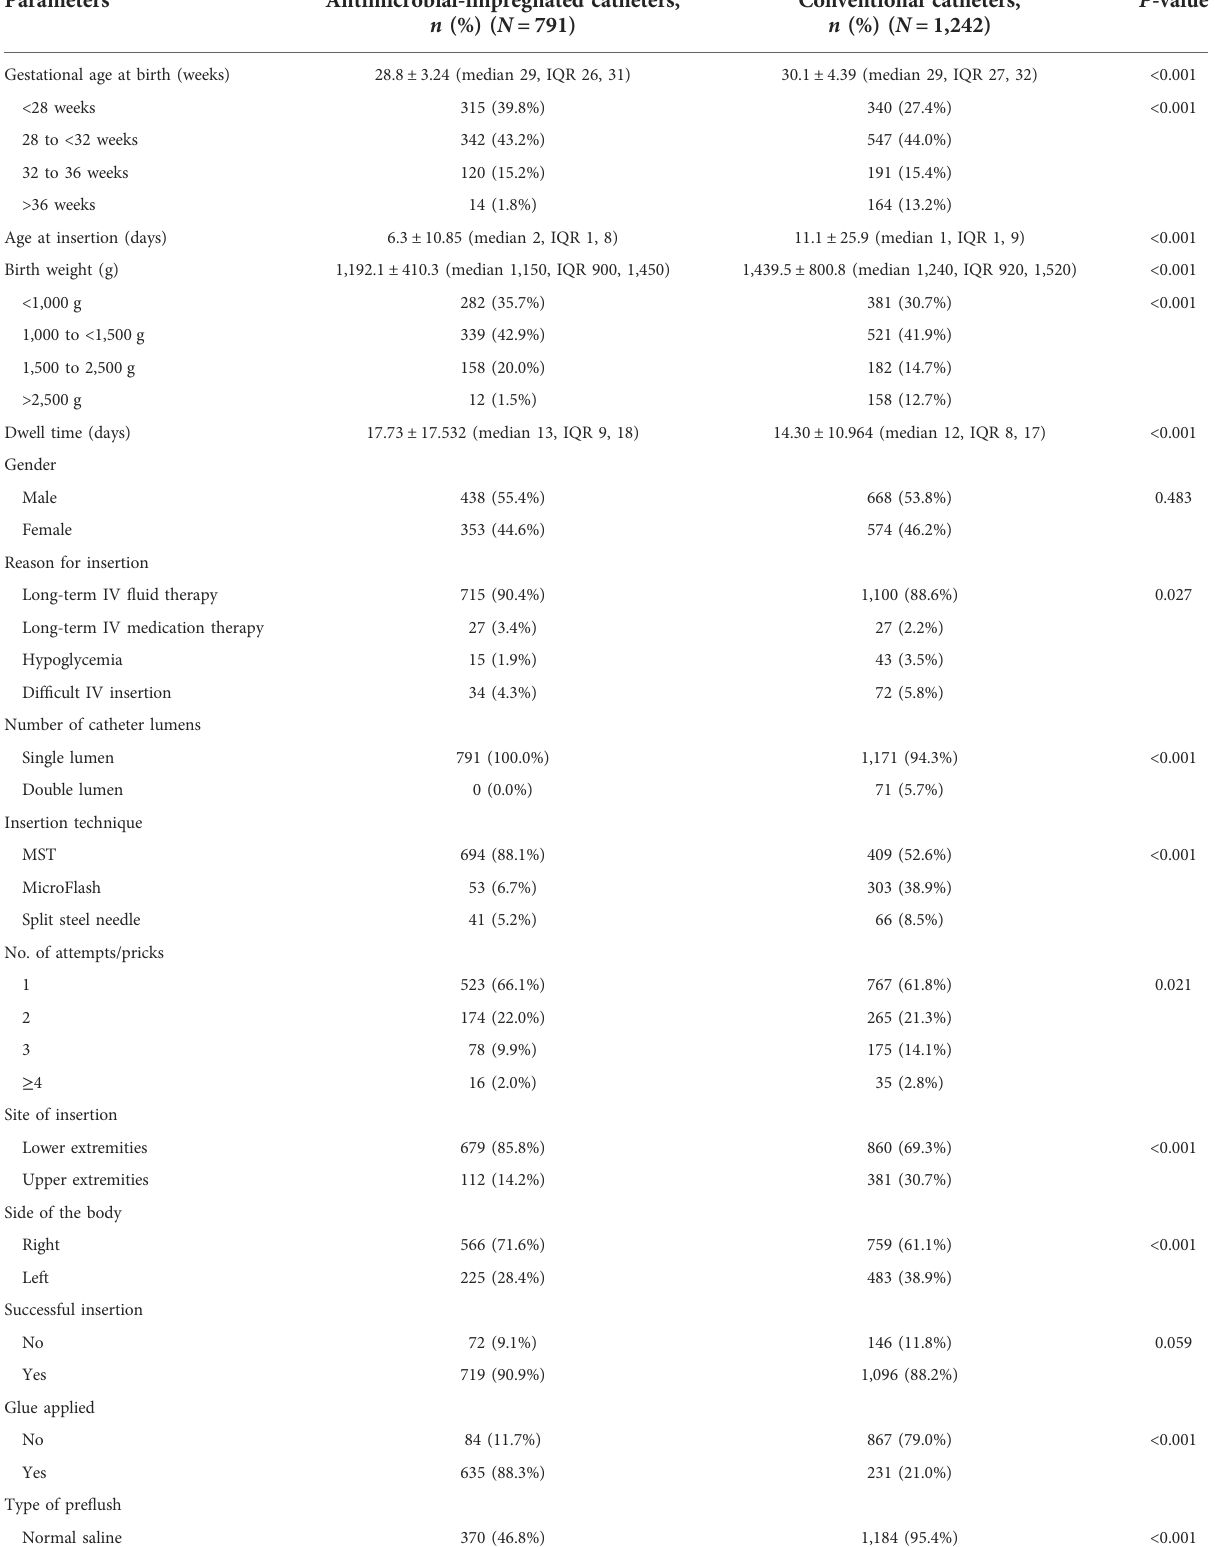
TABLE 3 Association between catheter types and other parameters.